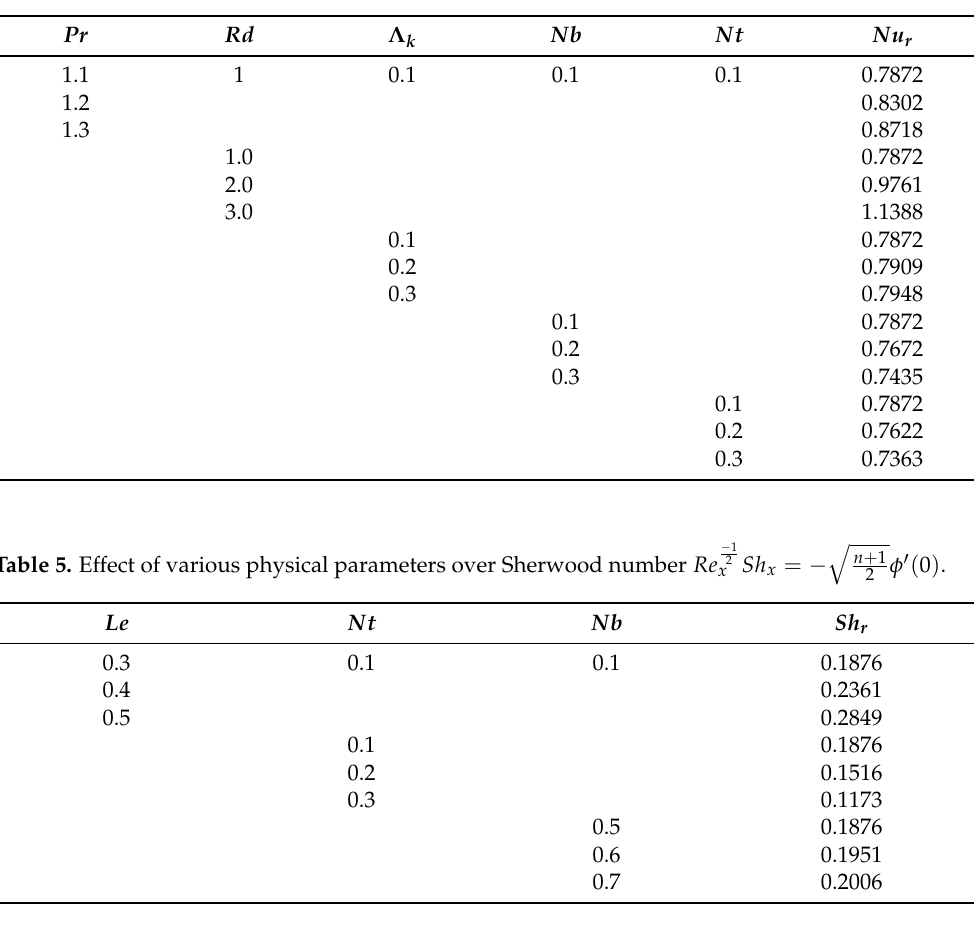
Table 4. Effect of various physical parameters over Nusselt number Re